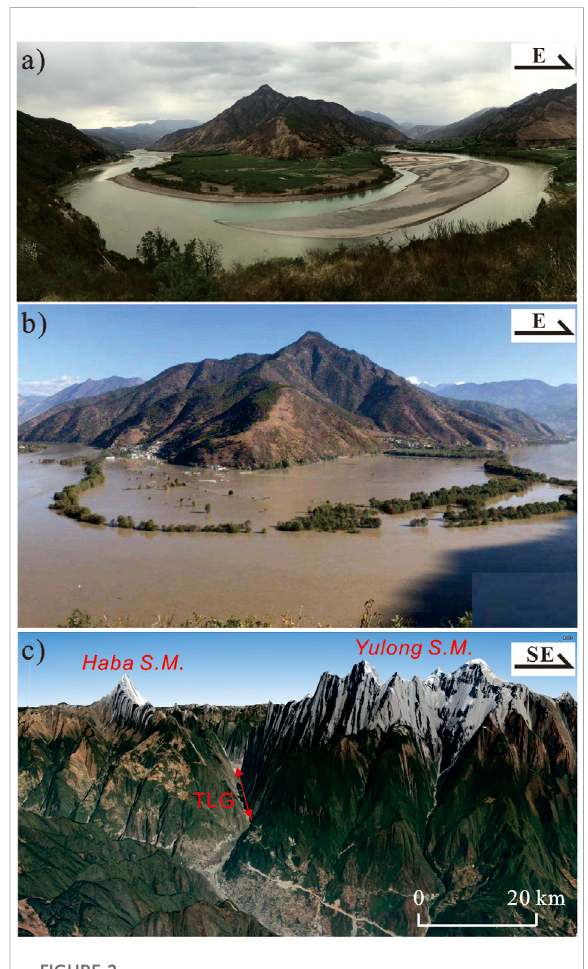
FIGURE 2 (A,B) PhotographsoftheFirstBendoftheYangtzeRiveratthe Shigu area. Picture (A) was taken on 14 April 2018 and picture (B) was taken at 8:45 h on 15 November 2018, when the area was inundated by the outburst fl ood caused by the broken Baige landslide dam. Picture (B) is from the website www.chinanews. com. (C) Oblique Google Earth image illustrating that the channel and valley narrowed sharply at the Tiger Leaping Gorge (TLG); terrain contrast is 3.0 times that of the actual. SM: Snow